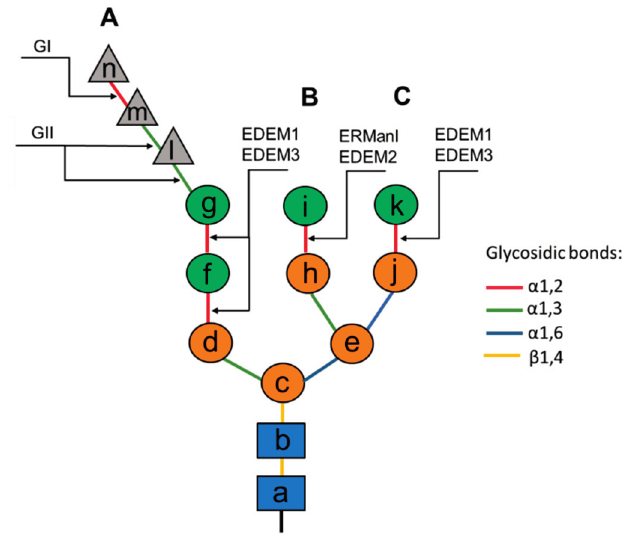
Figure 1. Structure of N- linked oligosaccharides. The pre-formed oligosaccharide covalently attached to Asn-Xxx-Ser/Thr sequences of nascent polypeptide chains is composed of three glucoses (grey triangles), nine mannoses (green and orange circles) and two N- acetylglucosamines (blue squares). Mannose residues that are removed by members of the glycosyl hydrolase family 47 (ER mannosidase I (ERManI) or EDEM1, EDEM2, EDEM3) are marked as green circles. It should be noted that extensive trimming of these mannoses by ERManI and/or Golgi endomannosidases was also reported (see text). Glucose n is removed by glucosidase I (GI), glucose residues m and l are both removed by glucosidase II (GII). A, B and C define the oligosaccharide branch. Letters a–n specify particular sugar residues. These letters are used throughout the text. The type of glycosidic bond is shown in